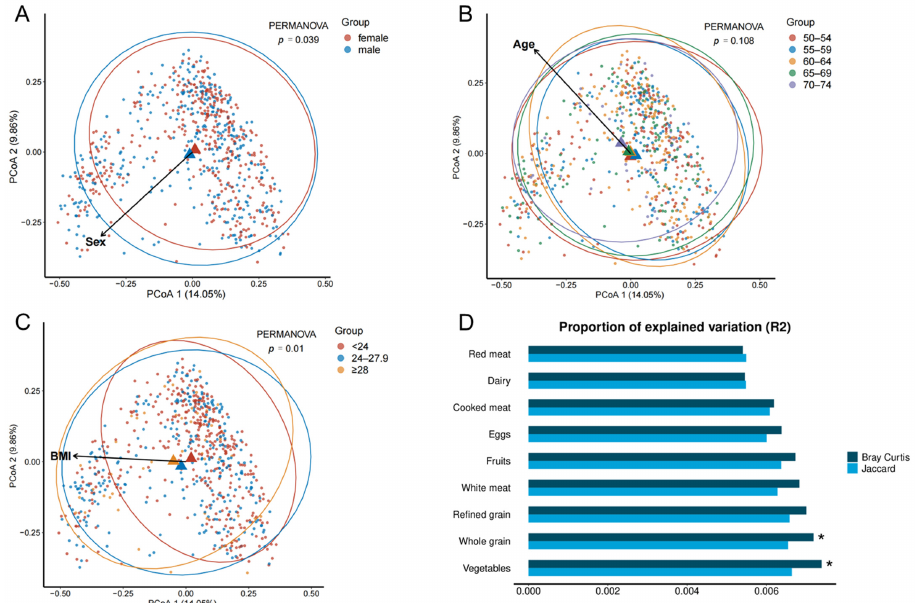
Figure 3. Variation in the gut microbiota composition represented by unconstrained PCoA based on the distance indexes. ( A – C ) present the grouping patterns of gut microbiota composition based on sex, age, and BMI. ( D ) shows percentages of variation in gut microbiota composition explained by dietary variables using multi-adjusted permutational ANOVAs (999 permutations). PCoA, prin- cipal coordinate analysis. * p- value < 0.05.